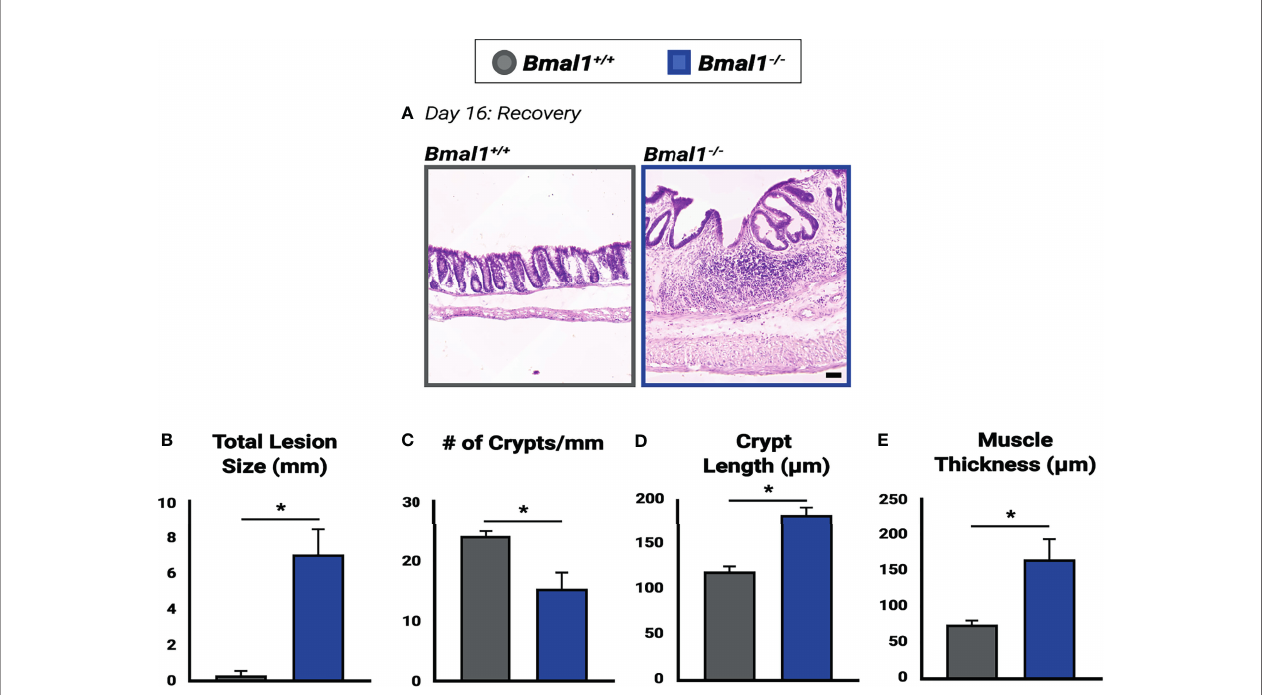
FIGURE 9 | Impaired recovery of Bmal1 -/- mutant colon tissue following DSS-colitis. (A) Representative images of Hematoxylin-Eosin staining in control versus Bmal1 -/- mutants. Day 16: Recovered colon tissue was morphologically assessed for resolution of colitis. (B) Increased total lesion size is evident in Bmal1 -/- mutant tissue (Unpaired t -test, *p=0.0090). (C) Decreased crypt density (Unpaired t -test, *p=0.0344) is present in Bmal1 -/- mutants, and Bmal1 -/- mutant colons also exhibit (D) increased crypt elongation (Unpaired t -test, *p=0.0032), and (E) increased muscle thickening (Unpaired t -test, *p=0.0354) indicating a disrupted regenerative response. (All error bars represent